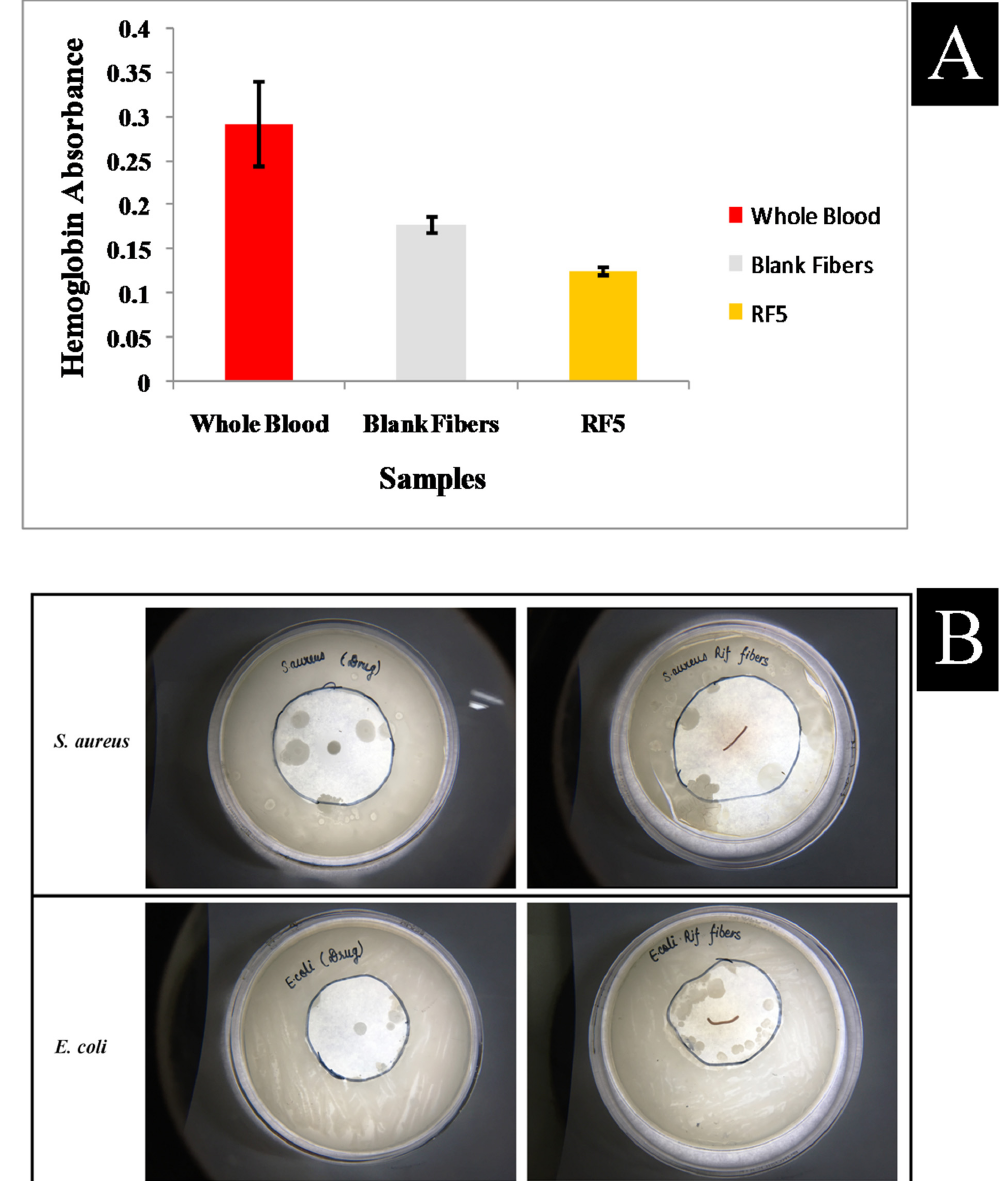
Figure 7. ( A ) Whole blood clotting of whole blood, blank microfibers and rifampicin loaded microfibers, ( B ) Antimicrobial activity of standard group (Rifampicin) and microfibers (RF5) against Staphylococcus aureus and Escherichia coli .